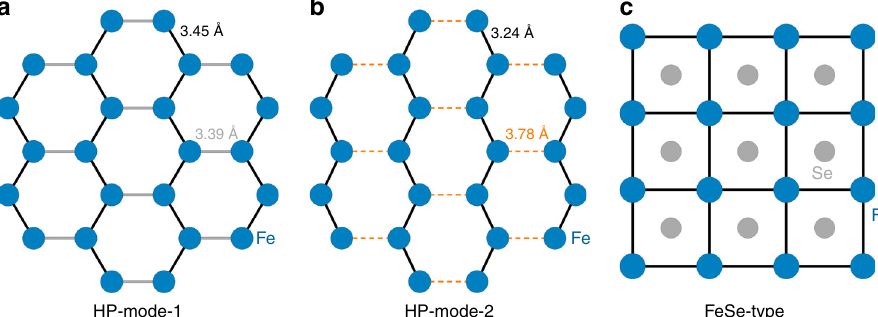
Fig. 5 High-pressure structure modes of Fe 2 + honeycomb lattice and comparison with FeSe-type tetragonal Fe 2 + lattice. a The proposed HP-mode-1 for FePSe 3 with slightly distorted Fe 2 + honeycomb lattice. b The proposed HP-mode-2 for FePSe 3 with seriously distorted Fe 2 + honeycomb lattice. The shortest or the near-shortest Fe – Fe bond lengths are highlighted by black and gray lines in the HP-mode-1 and black and yellow lines in the HP-mode-2, respectively. c Tetragonal Fe 2 + lattice in most Fe-based high- T c superconductors with FeSe-type layered